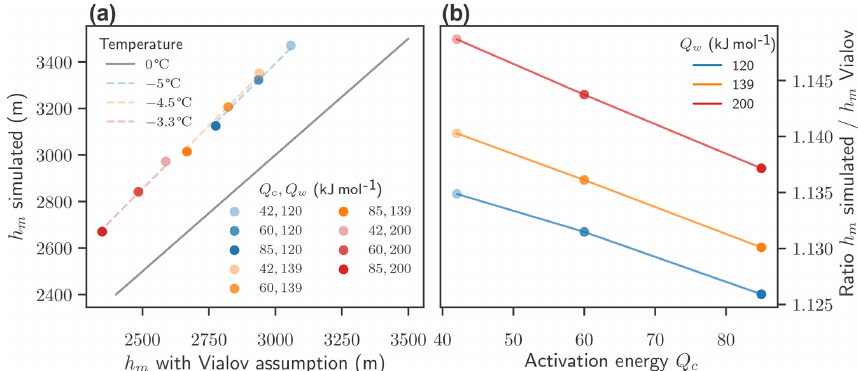
Figure 3. Comparison of simulated equilibrium thickness with analytical results. (a) Dots: maximal thickness h m of the simulated polyther- mal ice sheet versus the analytical solution for the maximal thickness h m of a temperate Vialov profile with the same flow parameters and accumulation rate. Colors indicate the flow–parameter combination. The grey line indicates identity. Short dashed lines indicate the analyti- cal h m with a temperature lower than the pressure melting point versus h m at the pressure melting point with the same flow parameters and accumulation rate. The temperature, which fits the simulated results best, is indicated in the legend. (b) Ratio of the simulated h m to the analytic h m (assuming a temperate ice sheet) versus Q c for different parameter combinations of Q c and Q w . The value of Q w is indicated by the